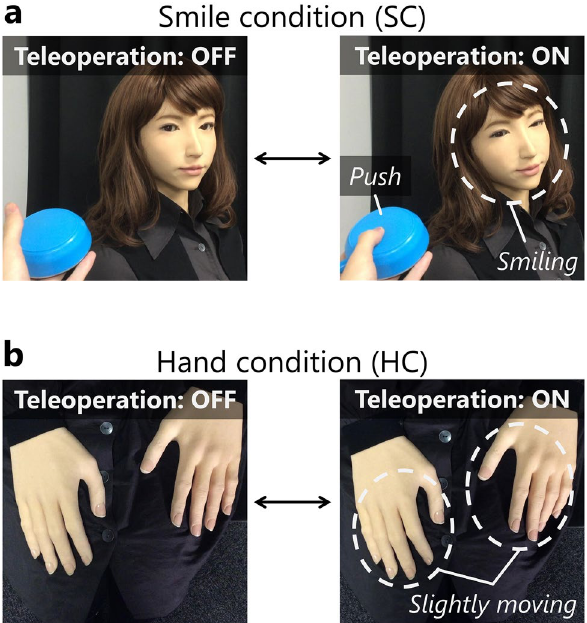
Figure 2. Examples of behavior of the android in teleoperation conditions (SC and HC): ( a ) Smile condition. When the button was pressed and held, the android retained the smile. ( b ) Hand condition. When the button was pressed and held, the hand of the android kept moving between slightly open and close.